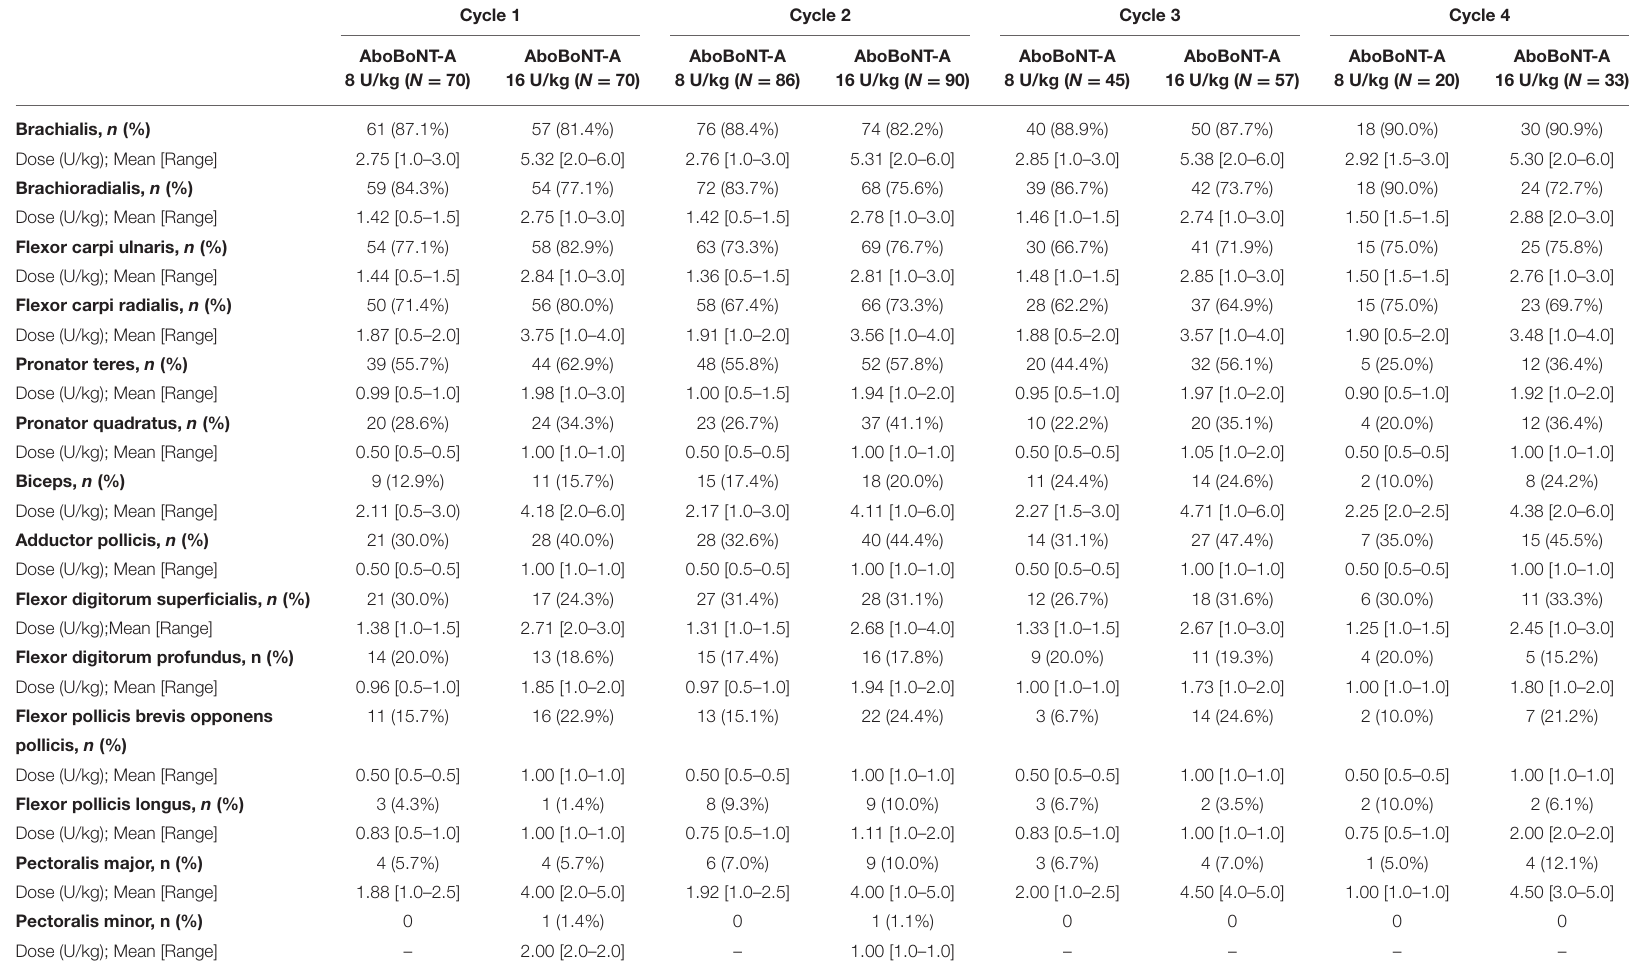
TABLE 2 | Mean [Range] abobotulinumtoxinA doses per upper limb muscle across treatment